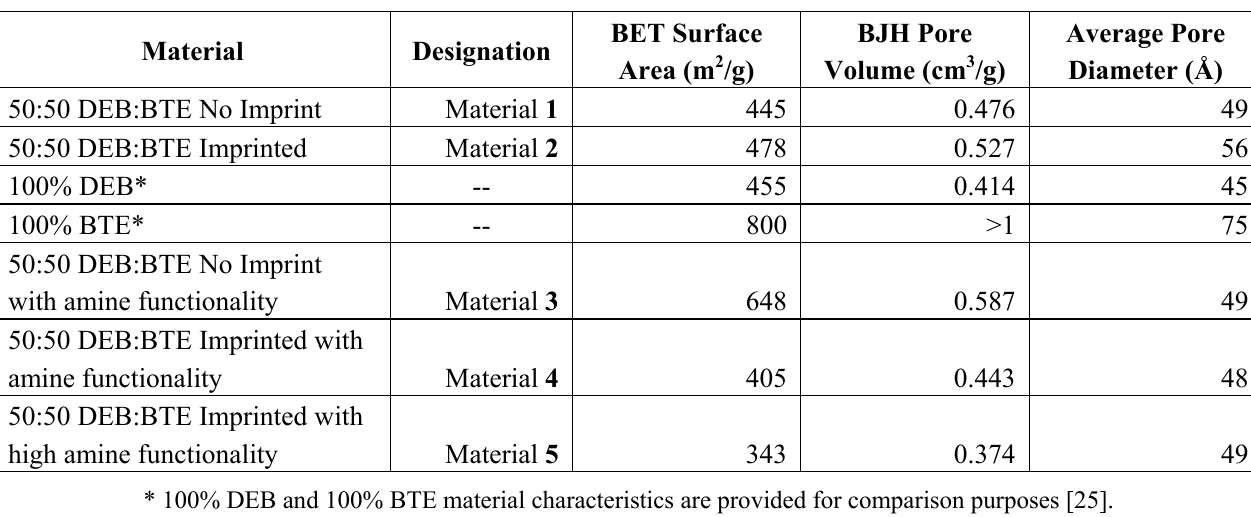
Figure 5. Esterification of the surfactant ( A ) to provide an analog of the paraoxon structure ( B